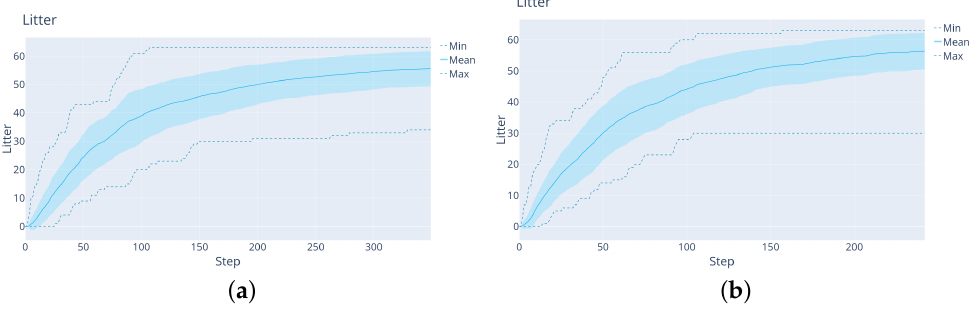
Figure 19. ( a ): The results of the collision-free Rainbow agent with the 3 × 15 sensor on 32 × 32 × 24 maps. ( b ): The results of a similar agent but with the 5 × 15 sensor on 27 × 27 × 24 maps (the version used for DDDQN). Table 1. Numerical comparison between all the agents , in terms of how fast they find litter early on (after 50 steps) and the total amount of litter found at the end of the trajectory. The smaller-map results are given above the double line, and the larger-map results below this line. The cyan background highlights the best agent for each type of map. In all the experiments the amount of false-positive findings were between 0.15 and 0.4 L items on average, i.e., very low. 50 Steps End of Trajectory Agent Litter % Litter LM 14.5 DDDQN l = 10, h = 100 16.9 Deep Rainbow l = 1, h = 25; no coll. LM Deep Rainbow l = 1, no entropy ( h → ∞ ) Deep Rainbow l = 1, h = 10 15.6 Deep Rainbow l = 1, h = 100 19.3 Shallow Rainbow l = 1, h = 100 11.9 Deep Rainbow l = 1, h = 25; no